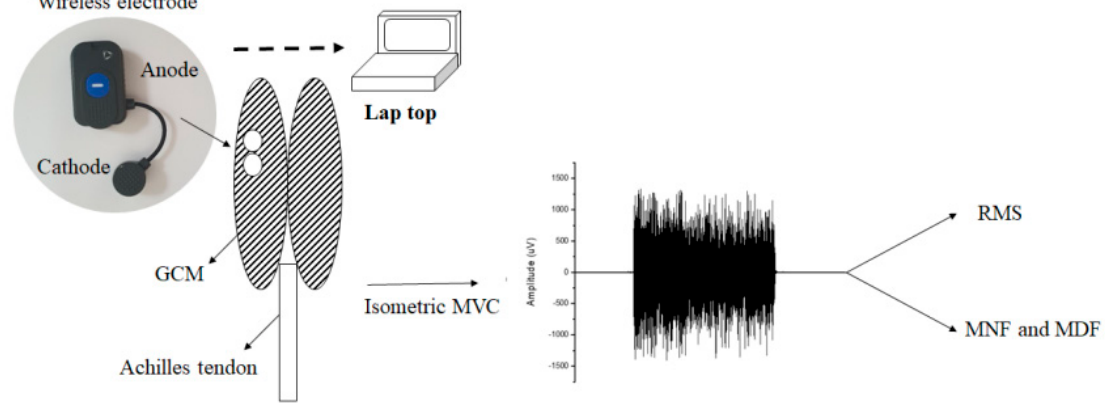
Figure 1. Surface electromyography detection and analysis. This schematic illustration shows the positioning of surface electrodes using wireless electrode devices. Signals obtained during isometric MVC. Note: GCM, medial gastrocnemius; MVC, maximal voluntary contraction; RMS, root mean square; MNF, mean power frequency; MDF = median frequency.